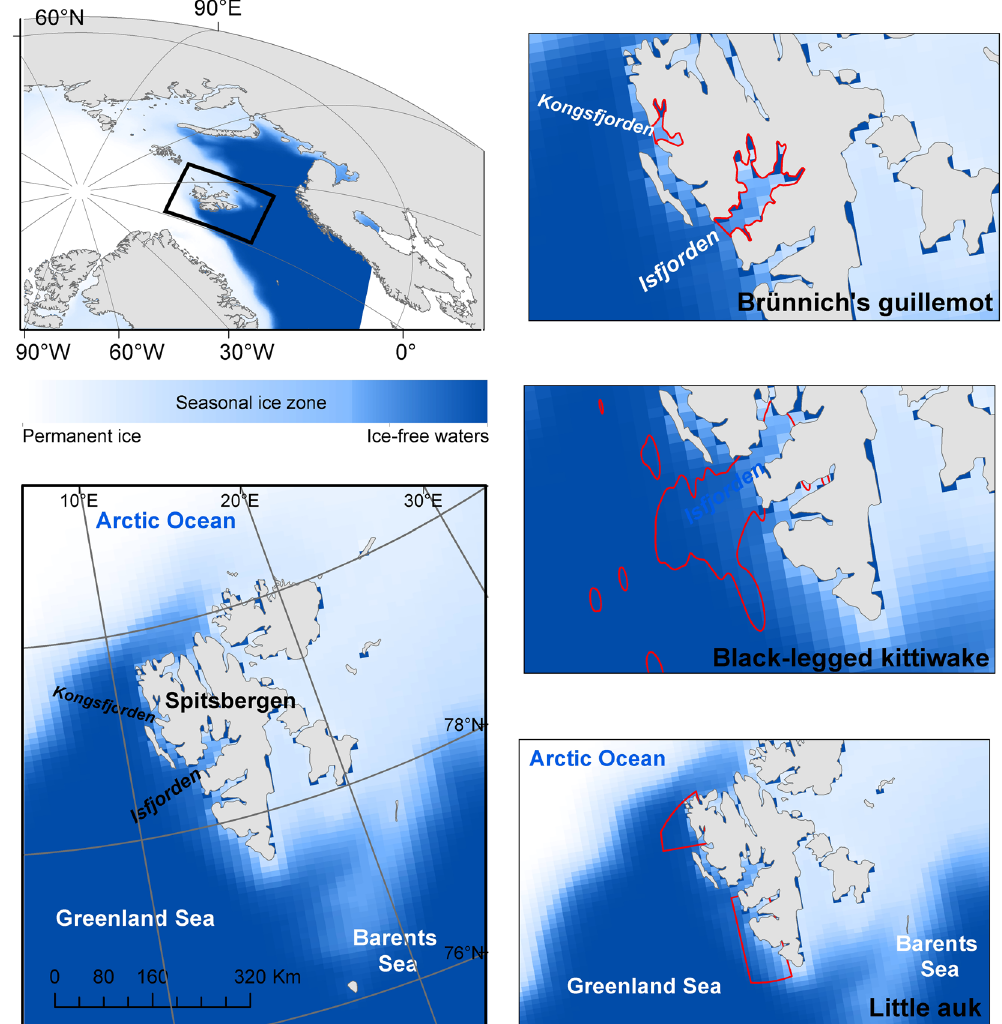
Figure 1. Study area and species. Based on GPS loggers and δ 13 C values, we determined the most likely foraging areas for the Brunnich’s guillemots, black-legged kittiwakes and little auks breeding in the Svalbard Archipelago. These were subsequently used for investigating the sequence of environmental and biological processes driving food availability and, ultimately, seabirds’ reproductive performances. Background colors pinpoint the seasonal ice zone, based on daily images of ice extent for the 2006–2016 period (National Snow and Ice Data Center, Boulder, Colorado USA). Dark-blue in cells along the coastline indicate no data and are excluded from the analyses. Map generated with ArcGIS 10.2.1 (ESRI, Redland), www.arcgis.com. Organizational License provided by